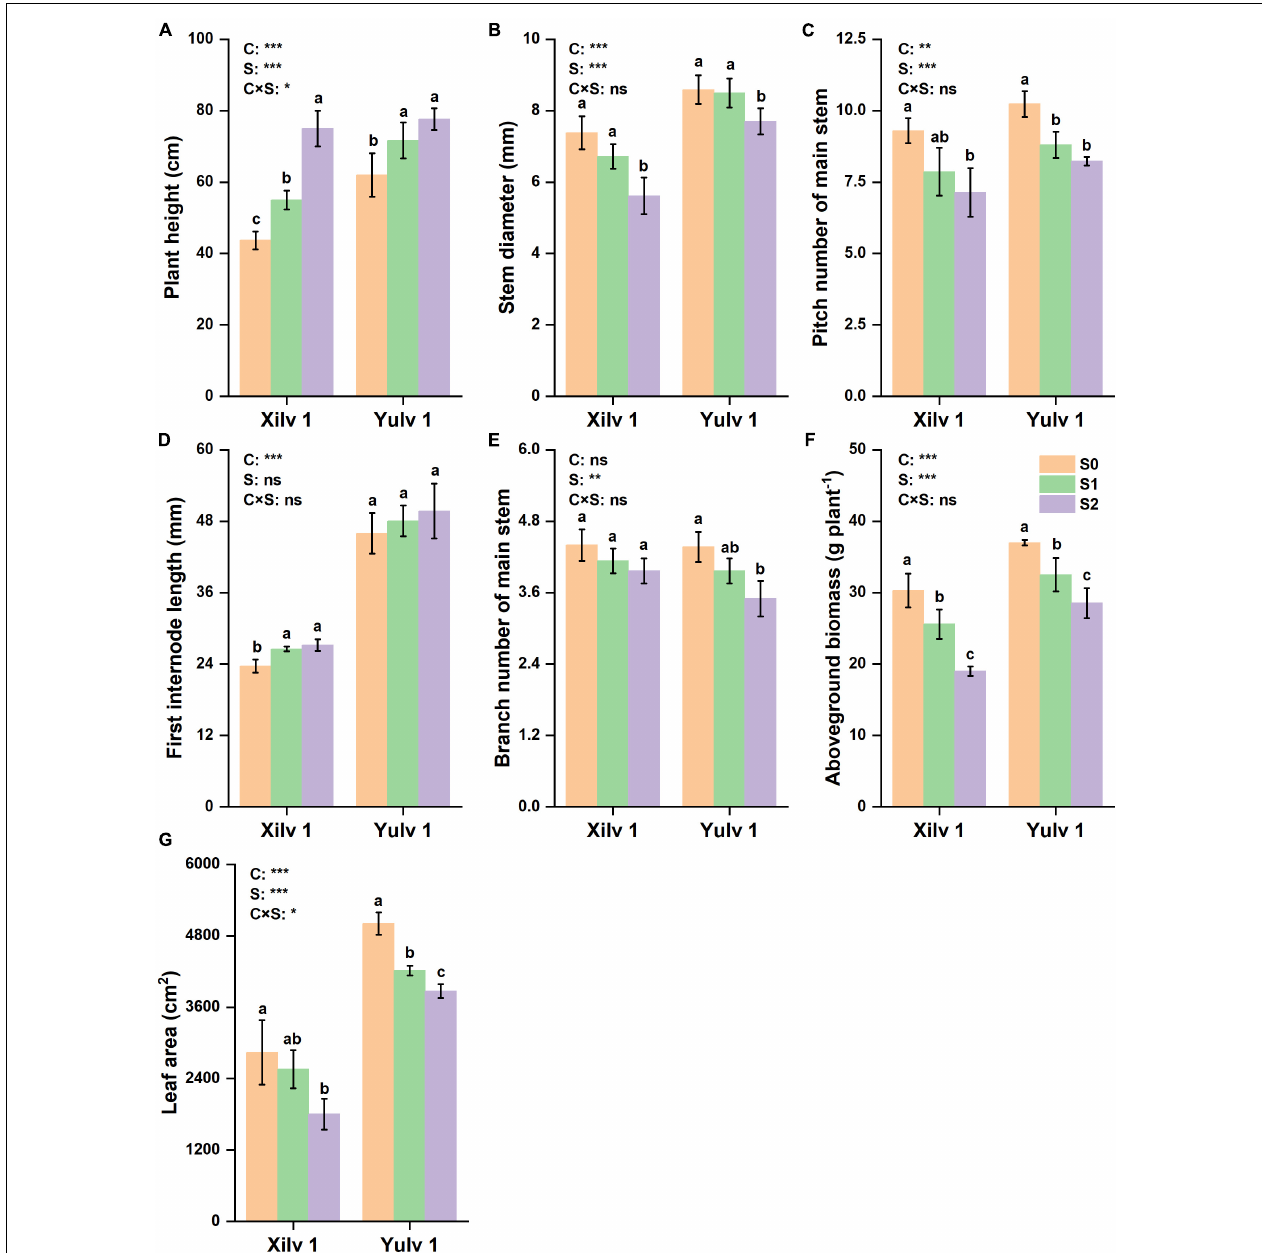
FIGURE 2 | Effect of shading stress on the agronomic traits in mung bean. (A) Plant height; (B) stem diameter; (C) pitch number of main stem; (D) first internode length; (E) branch number of main stem; (F) aboveground biomass; and (G) leaf area. Values followed by a different letter are significantly different at p < 0.05. S0, no shading; S1, moderate shading; and S2, severe shading. *, **, and *** significant at the 0.05, 0.01, and 0.001 probability levels, respectively. ns, no significant difference.